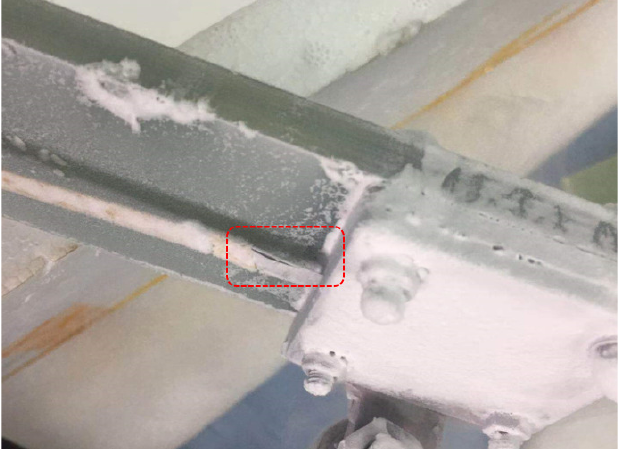
Figure 5. Damage of the superconducting tape occurred under impact current of 690 A and pulse Figure 5. Damage to the superconducting tape occurred under an impact current of 690 A and pulse duration of 1000 ms. duration of 1000